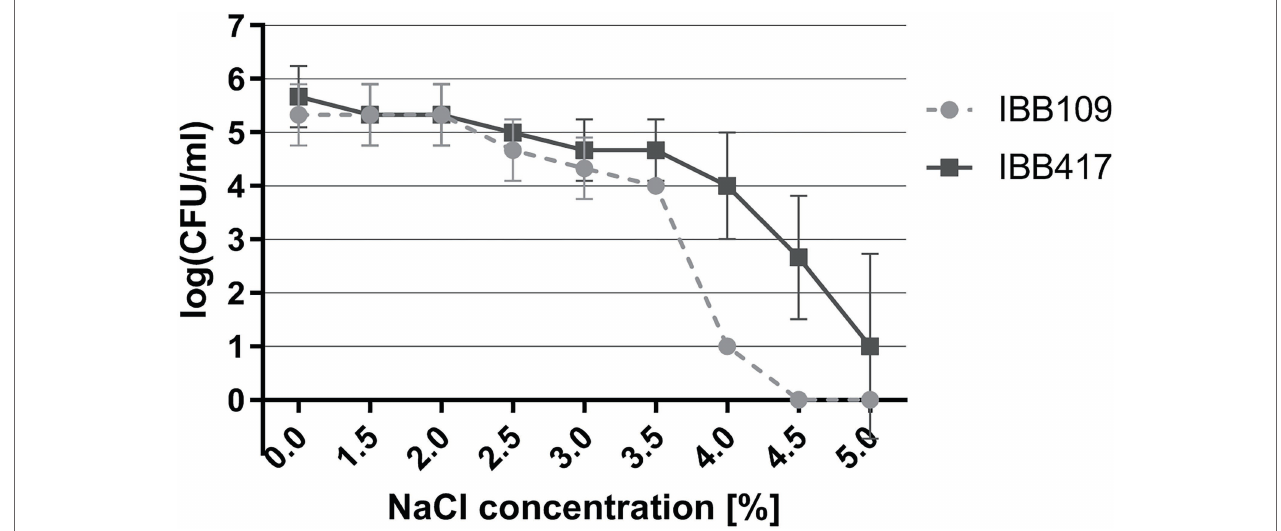
FIGURE 4 | Tolerance of L. lactis strains to osmotic stress. Strains were exposed to NaCl (0%–5%; w/v) by spot assay tests. Cell viability is presented as changes in log CFU ml − 1 values at increasing NaCl concentrations.